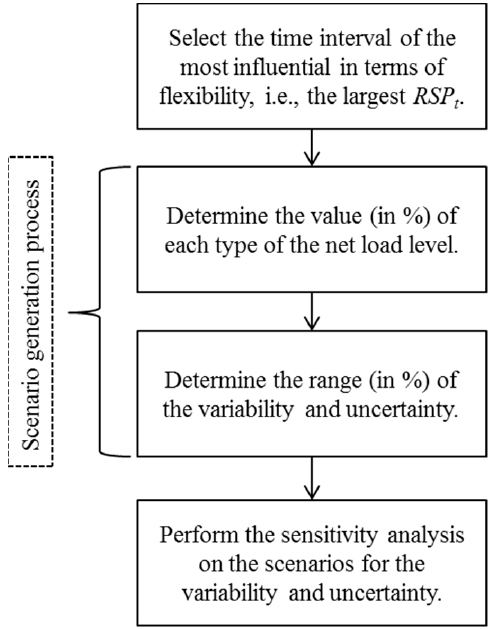
Figure 3. Process of scenario generation and sensitivity analysis.